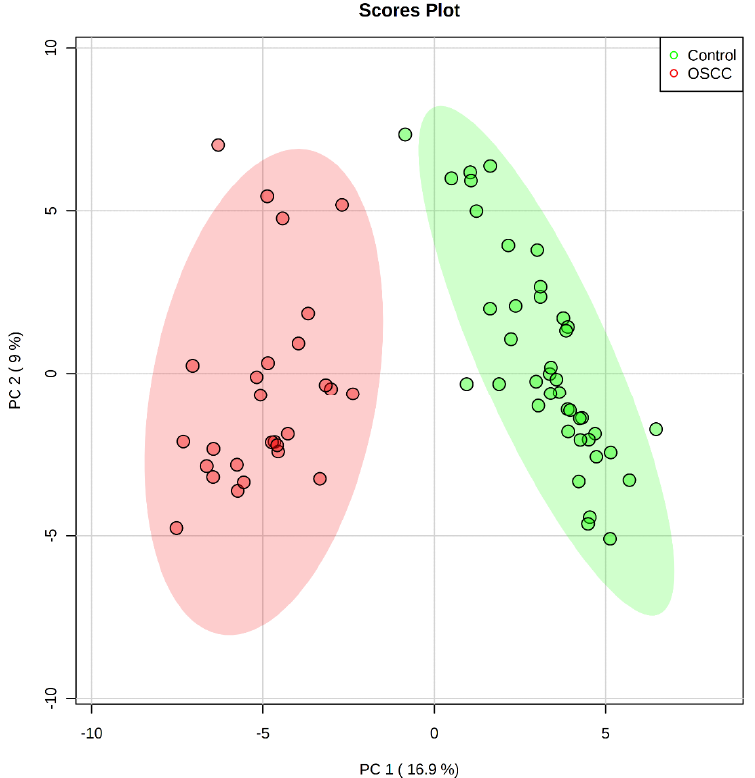
Figure 2. PCA score plot OSCC (green) and control (red) groups. Ellipses represent the loci of maximum variance of data.